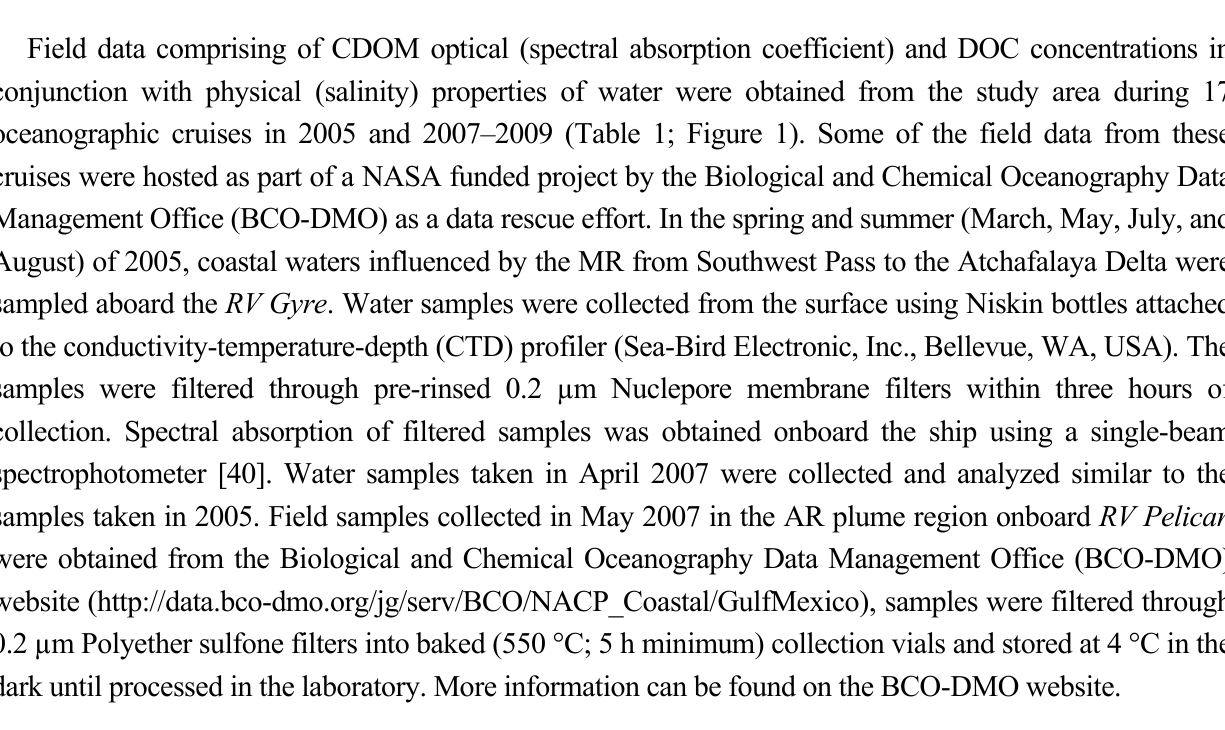
Table 1. Field data from cruises in the northern Gulf of Mexico along with mean values for (412), dissolved organic carbon (DOC) concentration, salinity, and S.D., and Geometric a CDOM mean for each